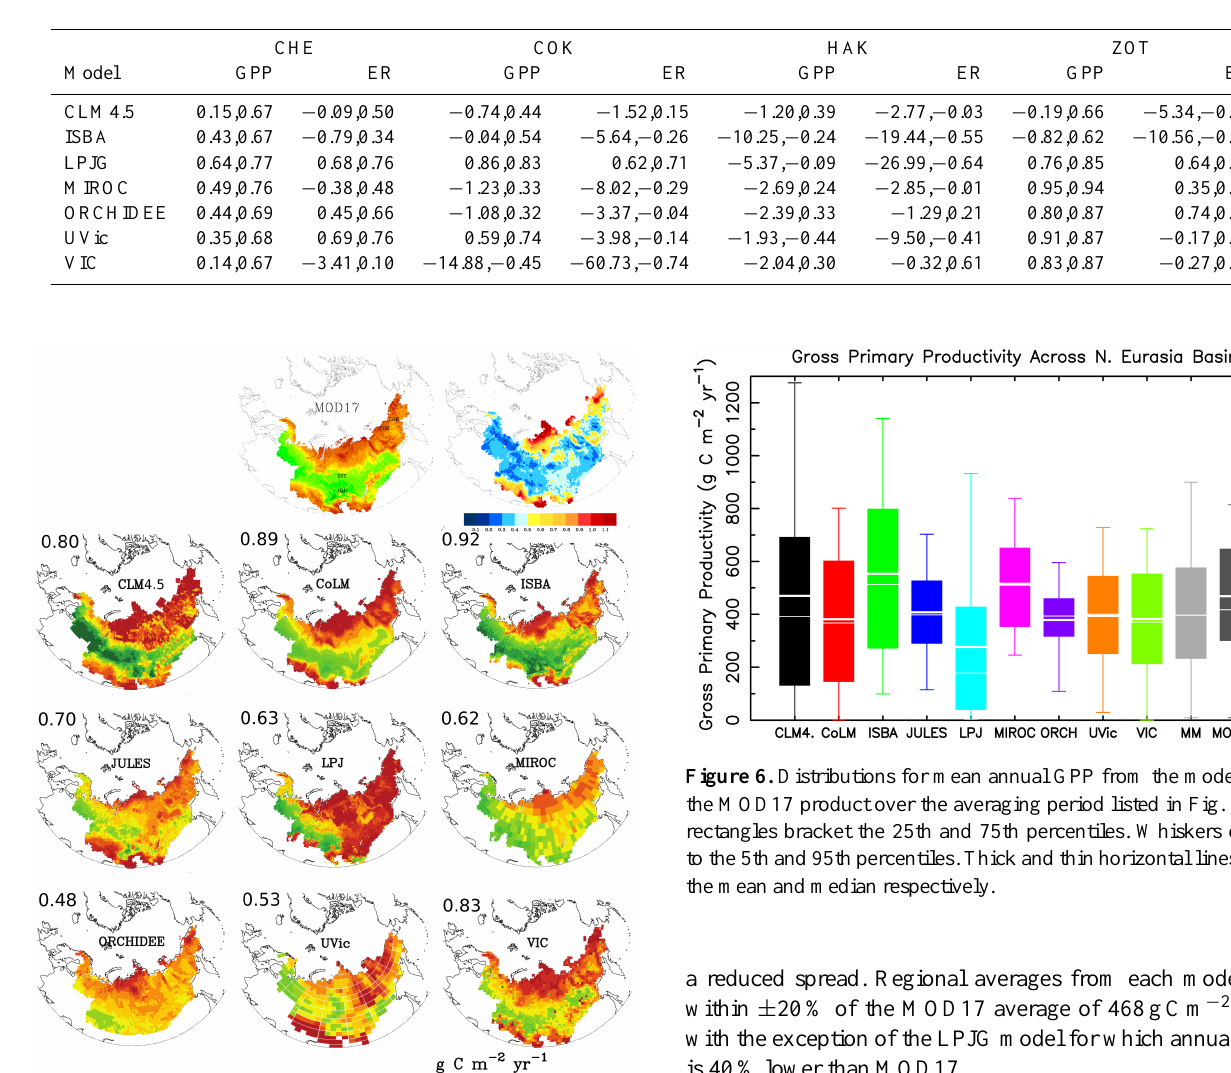
Table 5. Nash-Sutcliffe coefficient of efficiency ( E ) (Nash and Sutcliffe, 1970) and Willmott’s refined index of agreement ( d r ) (Willmott et al., 2011) for comparison of GPP and ER errors derived from comparisons at sites shown in Table 4.